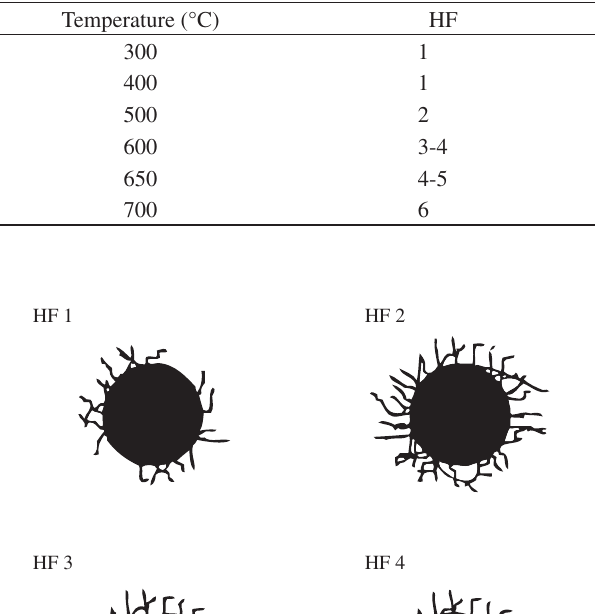
Table 1. Adhesion strength quality (HF) of titanium oxide films.